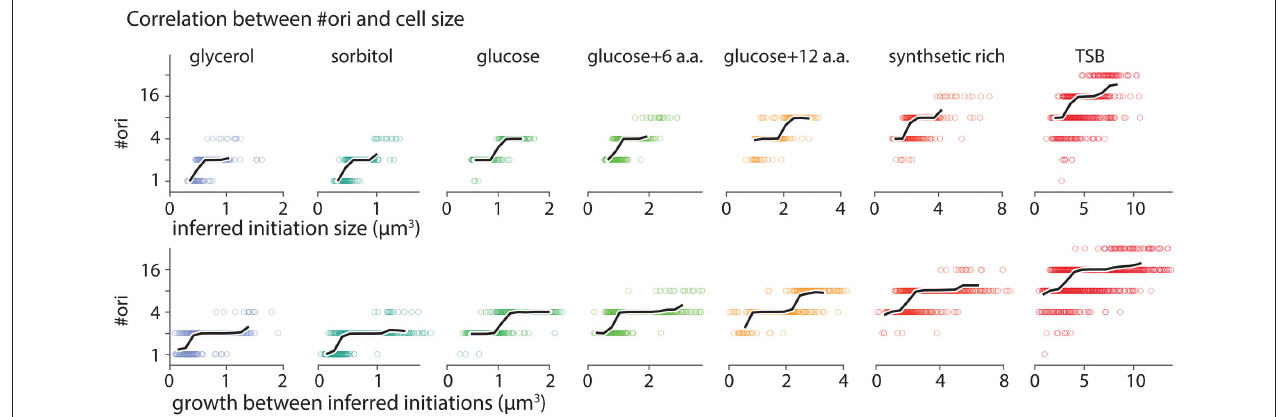
FIGURE A5 | Correlation between # ori and cell size. Number of origins, # ori , as a function of cell size at inferred initiation points (top panels) and as a function of growth between two consecutive initiations (bottom panel). # ori is a discrete parameter taking only values in exponents of two ( # ori = 1, 2, 4,...). However, it shows a positive correlation with cell size. Black lines present average # ori as a function of inferred initiation size and growth between replication initiations.